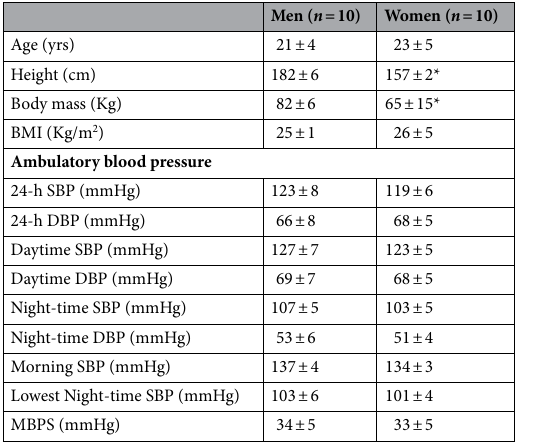
Table 1. Participant baseline data. Values are means ± SD. BMI body mass index, SBP systolic blood pressure, DBP diastolic blood pressure, MBPS morning blood pressure surge. *Significantly different from men ( P <